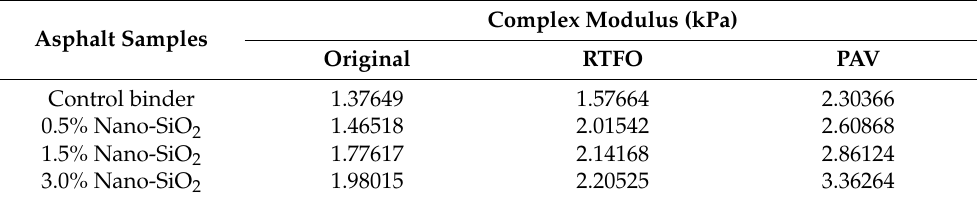
Table 6. Complex modulus for original and aged